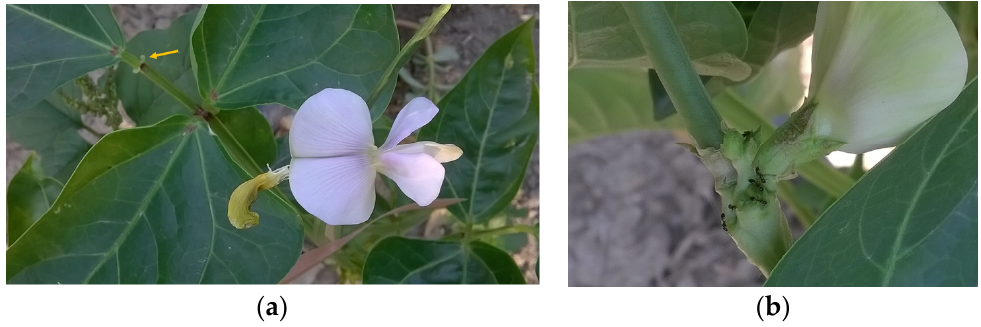
Table 3. Yield and yield related trait studied for each accession and coefficients of variation (CV%) for each accession and trait. Means ± SE in columns with different letters are significantly different at the 0.05 level, by Tukey’s HSD means comparison method.